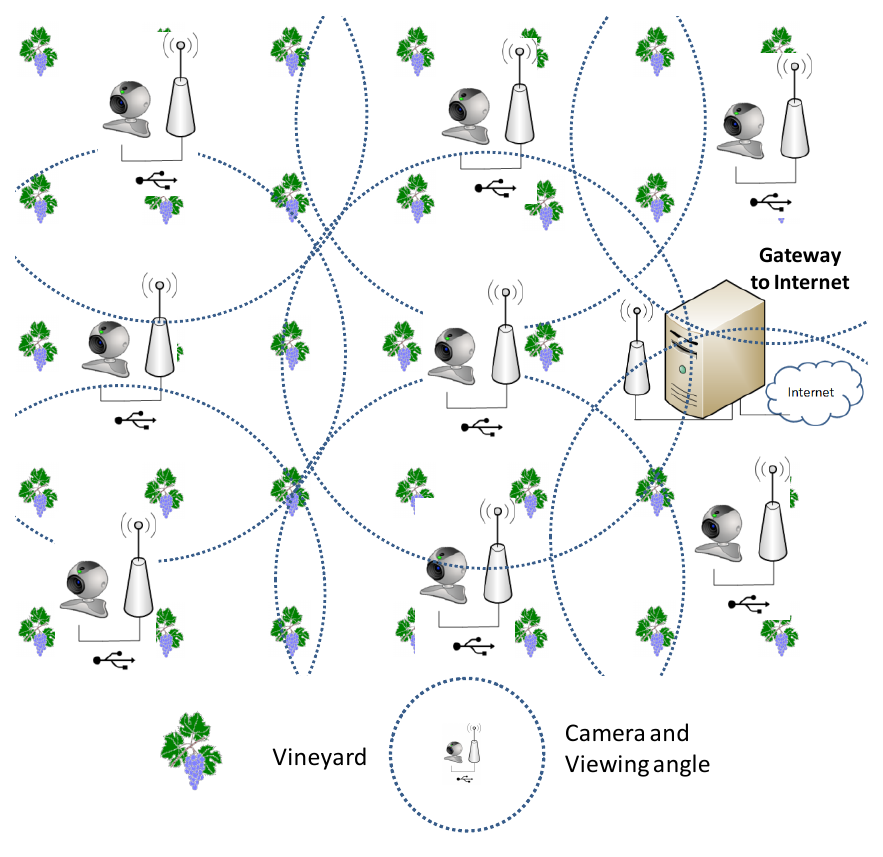
Figure 1. Vineyard monitored by